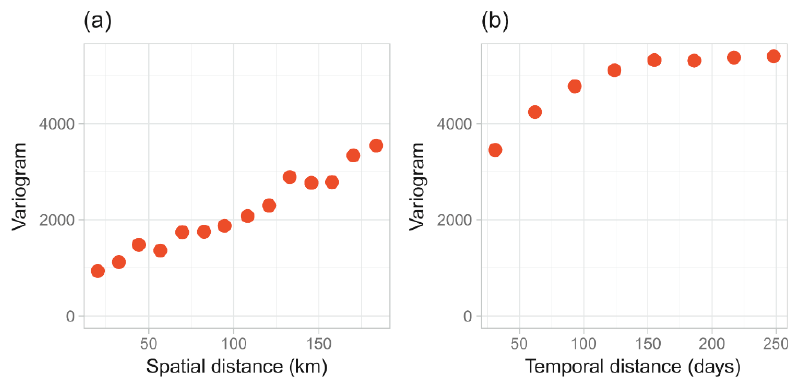
Figure 6. Marginal variograms of the residues: purely spatial ( a ) and purely temporal ( b ).